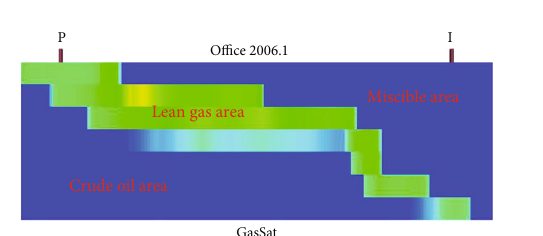
Figure 4: The 3D grid model of reservoir simulation.